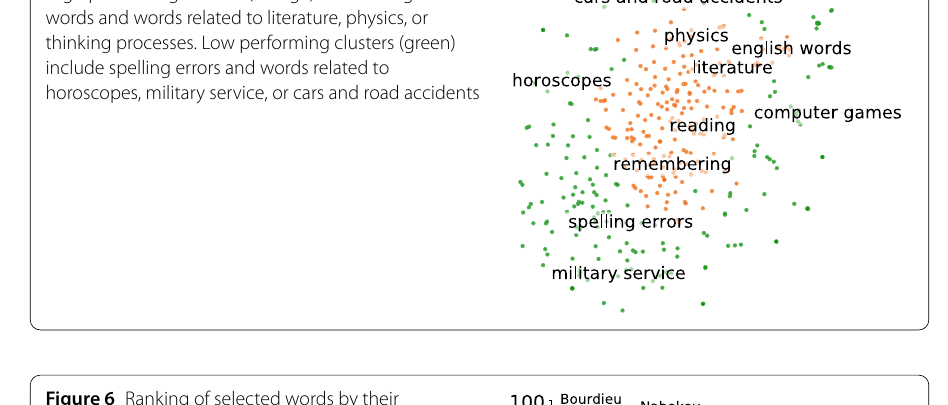
Figure 6 Ranking of selected words by their predicted score (translated from Russian). The application of the model to words from different domains confirms its face